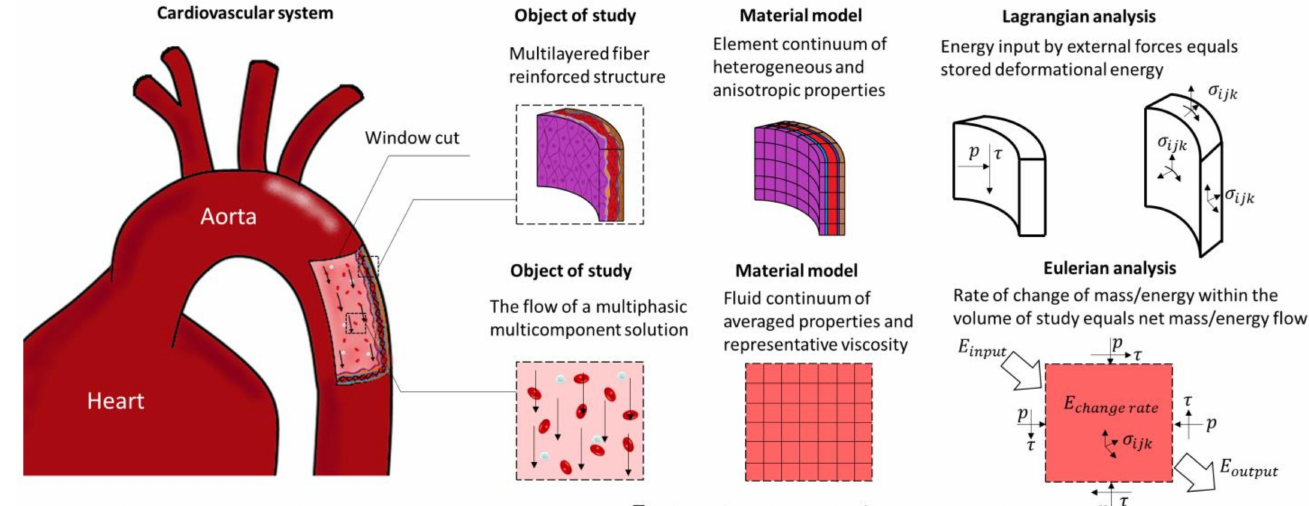
Figure 2. Representation of the modeling process of structural mechanics of cardiovascular tissue and fluid mechanics of the blood flow with a continuum mechanics approach. Structural mechanics of cardiovascular tissue are usually analyzed with a Lagrangian formulation that follows the defor- mation of a given portion of the tissue. Blood flow mechanics is usually analyzed with an Eulerian formulation, that is, analyzing the mass and energy balances on a fixed volume of interest through which the fluid